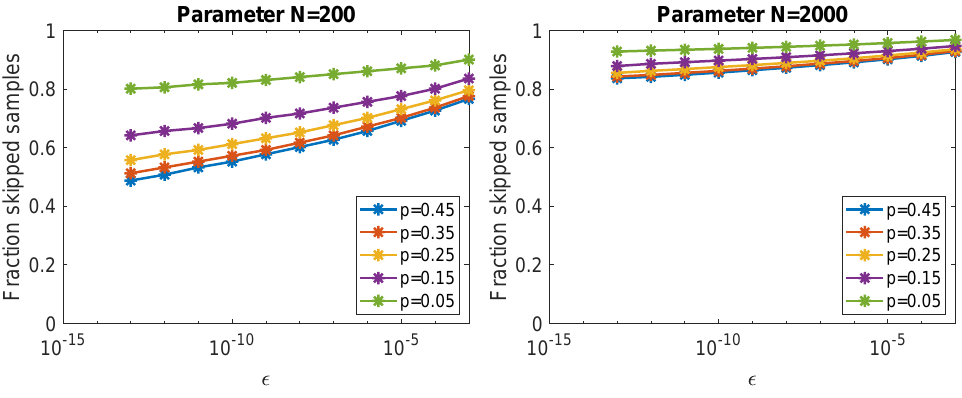
Figure 3. Support of the zeroth-order function for two different segment sizes and various values of p as a function of the allowed deviation.